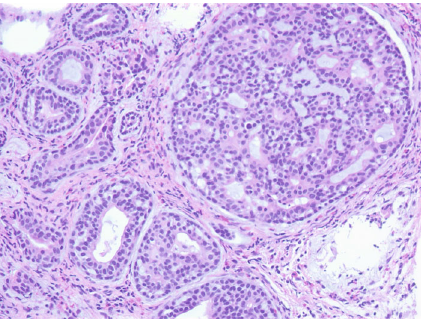
Figure 2: Microphotograph (200x) of the mass showing a very distinctive appearance and consists of di ff erent patterns. There were smaller gland or duct-like structures as well as larger nests with cribriform pattern. Some glands or spaces showed mucin-like or basophilic material. The tumor cells were round to oval with fi ne chromatin, small inconspicuous nucleoli, indistinct cell borders, and light nongranular cytoplasm. Mitotic fi gures were rare.